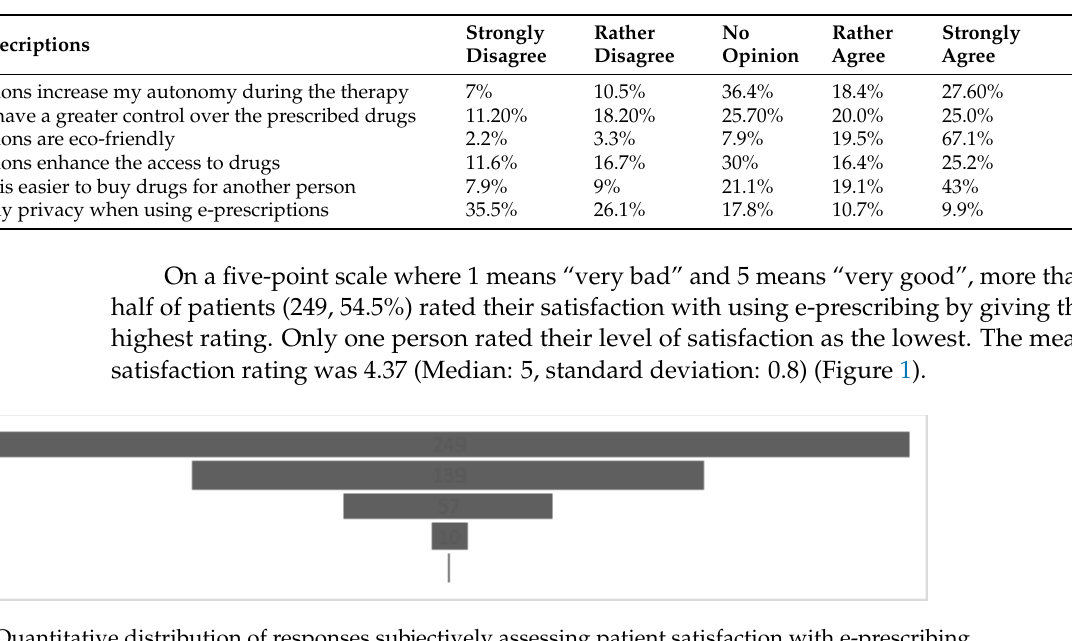
Table 5. Percentage distribution of responses evaluating e-prescribing.